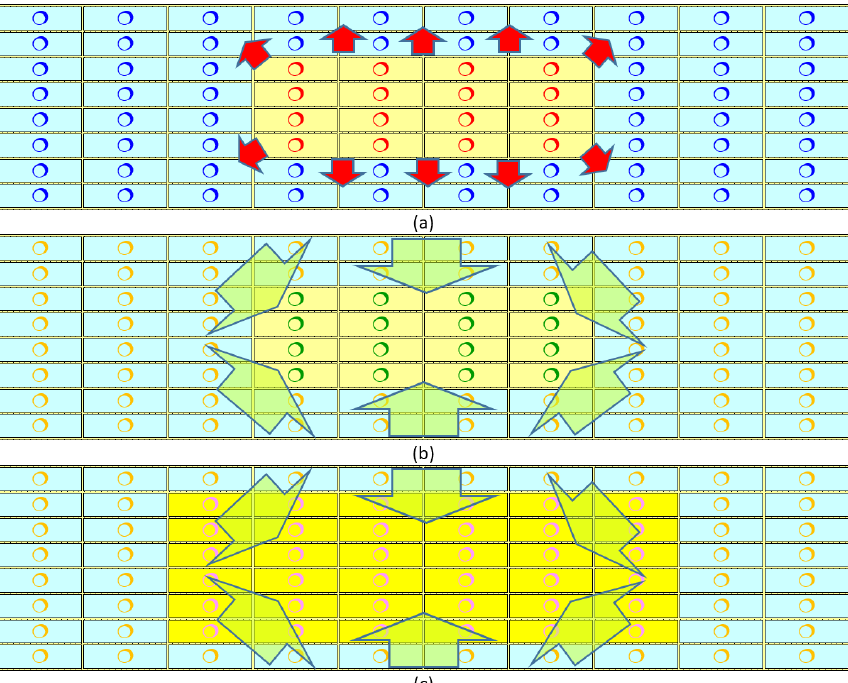
Figure 1. Schematic diagram to describe the characteristics of and differences among Radiation- Induced Bystander Effect (RIBE), Radiation-Induced Rescue Effect (RIRE), and Radiation-Induced Field Size Effect (RIFSE). Irradiated cells are represented by yellow rectangles; irradiated nuclei (prior to mitigation of radiobiological effects) by red circles, and rescued nuclei (subsequent to mitigation of radiobiological effects) by green and pink circles. Non-irradiated bystander cells are represented by light blue rectangles; non-irradiated nuclei prior to and subsequent to receipt of bystander signals are represented by dark blue and orange circles, respectively. Red and green arrows represent bystander and rescue signals, respectively. ( a ) Irradiated cells release bystander signals to surrounding non-irradiated bystander cells, and the ensuing effects that occur in the bystander cells are referred to as RIBE. ( b ) Non-irradiated bystander cells release rescue signals to irradiated cells, which can mitigate the radiobiological effects in the irradiated cells, and this mitigation is referred to as RIRE. ( c ) Same as ( b ) but with a different ratio between the number of irradiated and non-irradiated cells, which leads to different levels of mitigation of radiobiological effects in the irradiated cells. The dependence of radiation-induced biological effects in a cell population on the irradiation field size (in addition to the absorbed dose) is referred to as RIFSE.